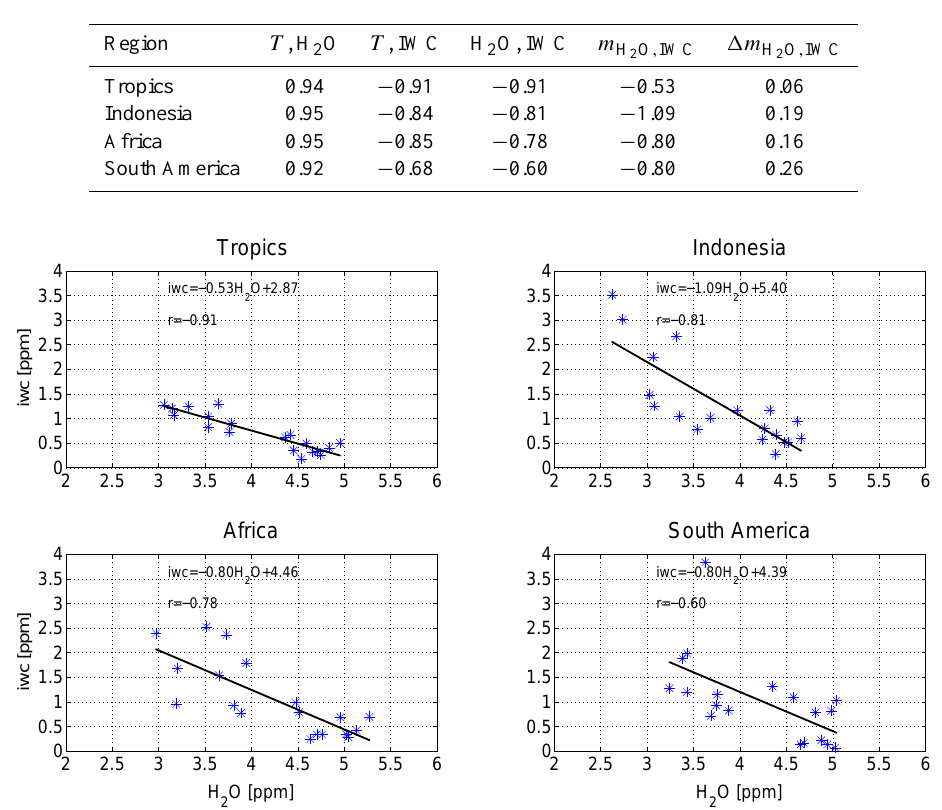
Fig. 5. Scatter plots of seasonal mean water vapor and IWC over the Tropics (8 ◦ S–8 ◦ N), Indonesia, Africa and South America at 100hPa. A clear anticorrelation is visible. The regression line has a slope of approximately − 1 which corresponds to the total conversion of water vapor to ice in the TTL. 1ppm of ice corresponds to about 0.1mgm − 3 in the TTL. These figures suggest that total water at 100hPa is roughly constant in the